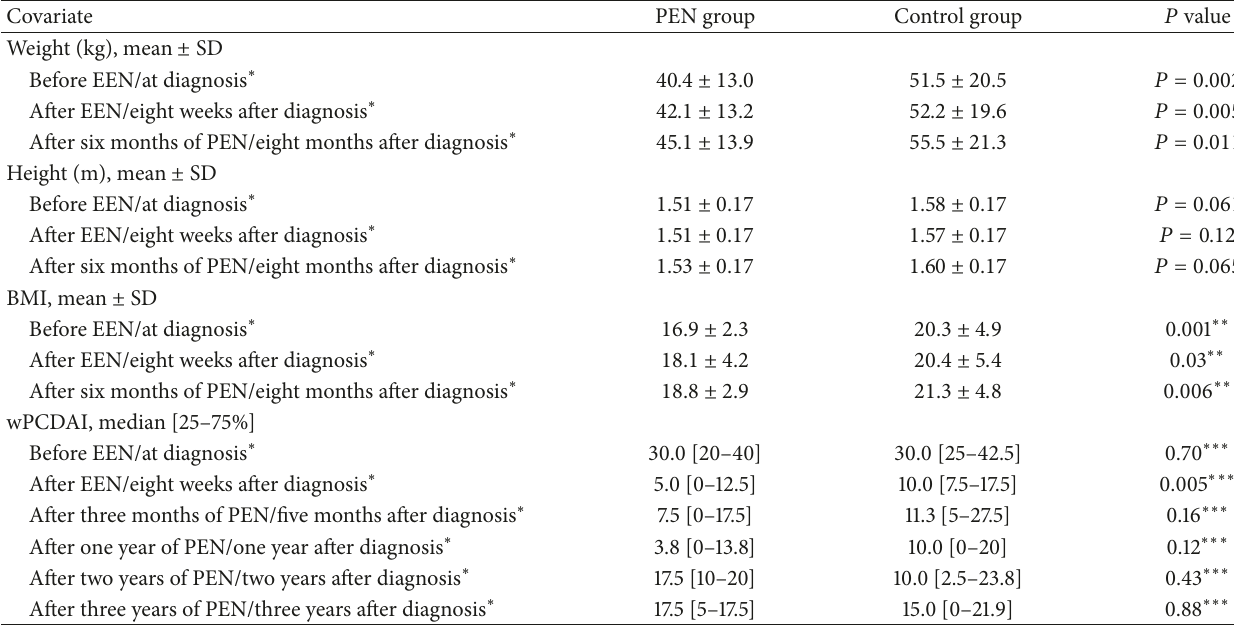
Table 4: Changes in weight, height, BMI, and wPCDAI over